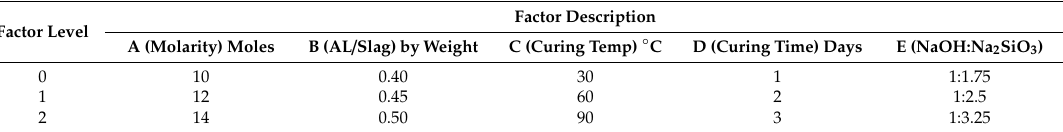
Table 6. Factor description